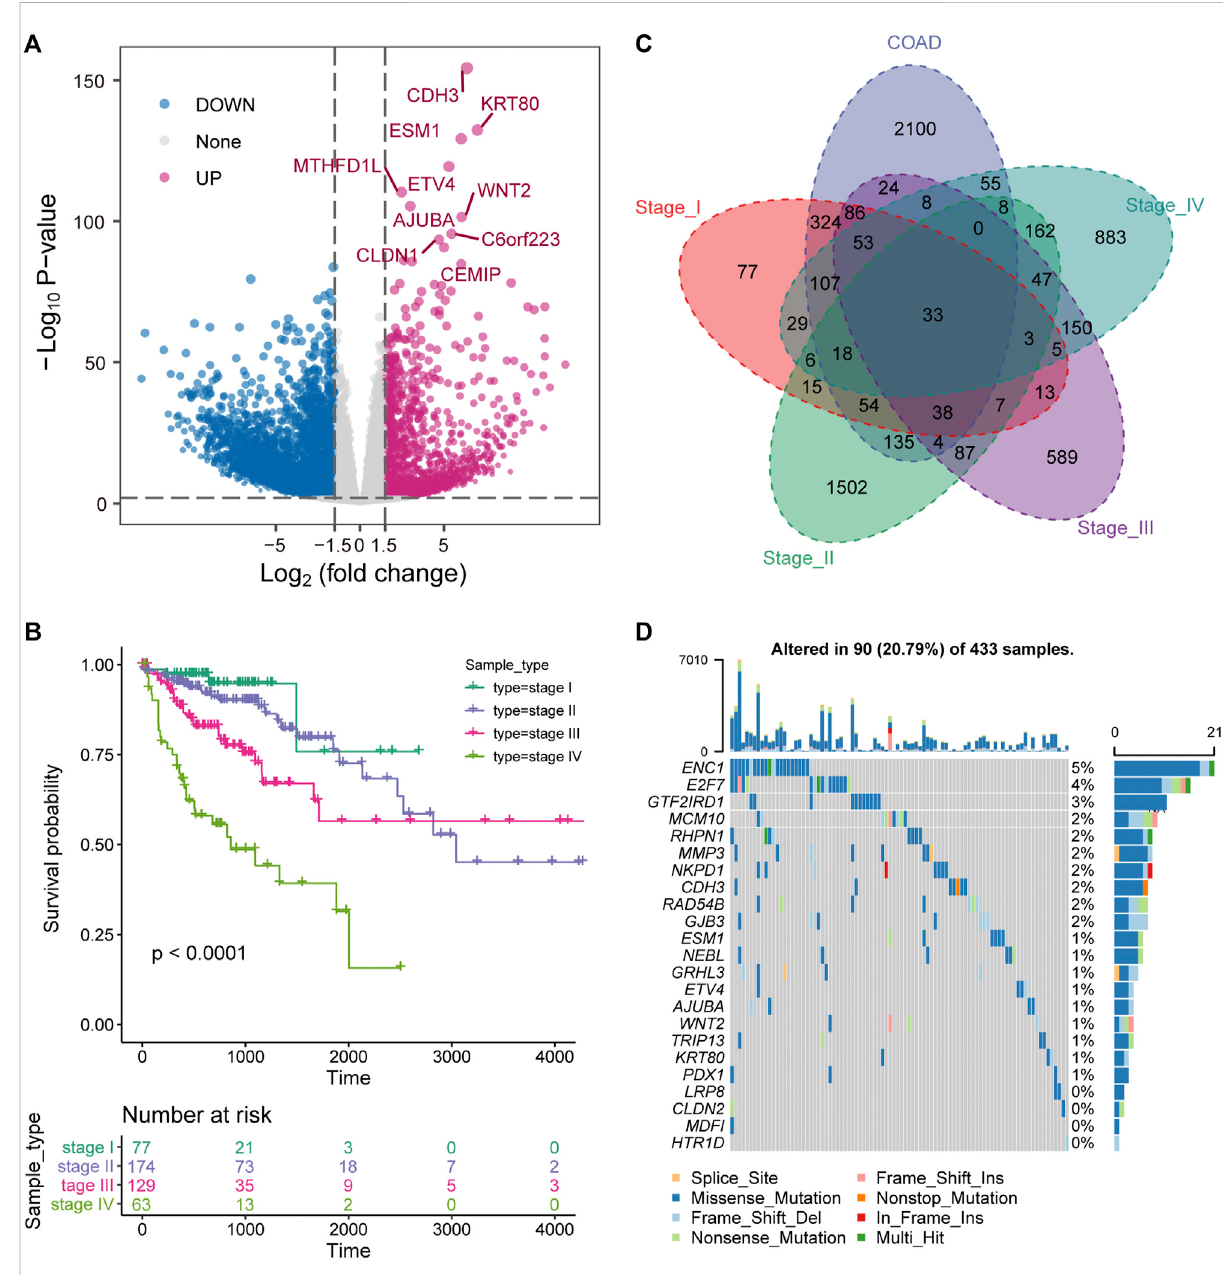
FIGURE 1 Stage-speci fi ctranscriptionalandmutationallandscapeinCOADdevelopment. (A) TheresultsoftheDEGsbetweenthewholetumorsampleof COAD and the normal sample are displayed by volcano plot. The x-axis represents log2 (Fold Change). The y-axis displays -log10 ( p value). (B) Kaplan-Meier (KM) curves depict the survival of patients in four stages for COAD. Log-rank test is used to calculate statistical signi fi cance. (C) Venn diagram shows the intersection of up-regulated genes between clinical stages and overall tumor samples. (D) The waterfall chart shows the mutationinformationofgenesthatarecontinuouslyup-regulatedinthedevelopmentofCOAD,andthemutationtypeofeachgeneineachsample is